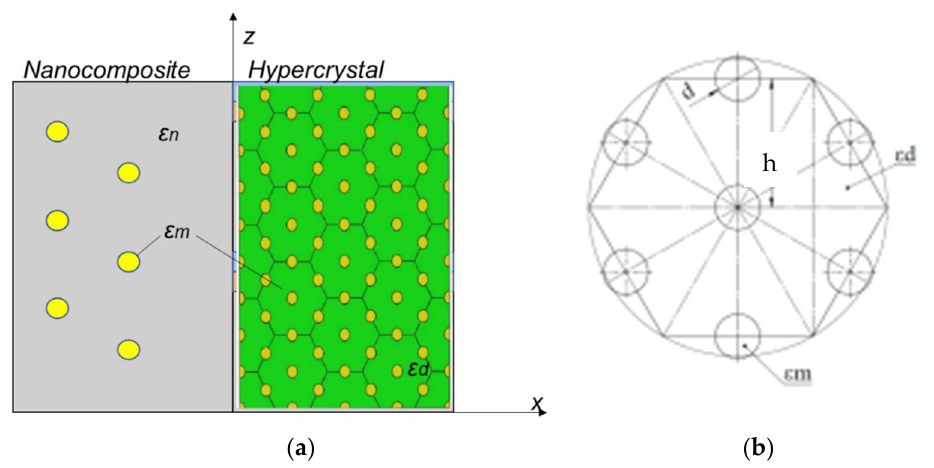
Figure 1. Schematic design under consideration, comprising a semi-infinite hypercrystal ( x > 0) and a nanocomposite with semiconductor inclusions ( x < 0) ( a ), metamaterial (hypercrystal) unit cell ( b ).